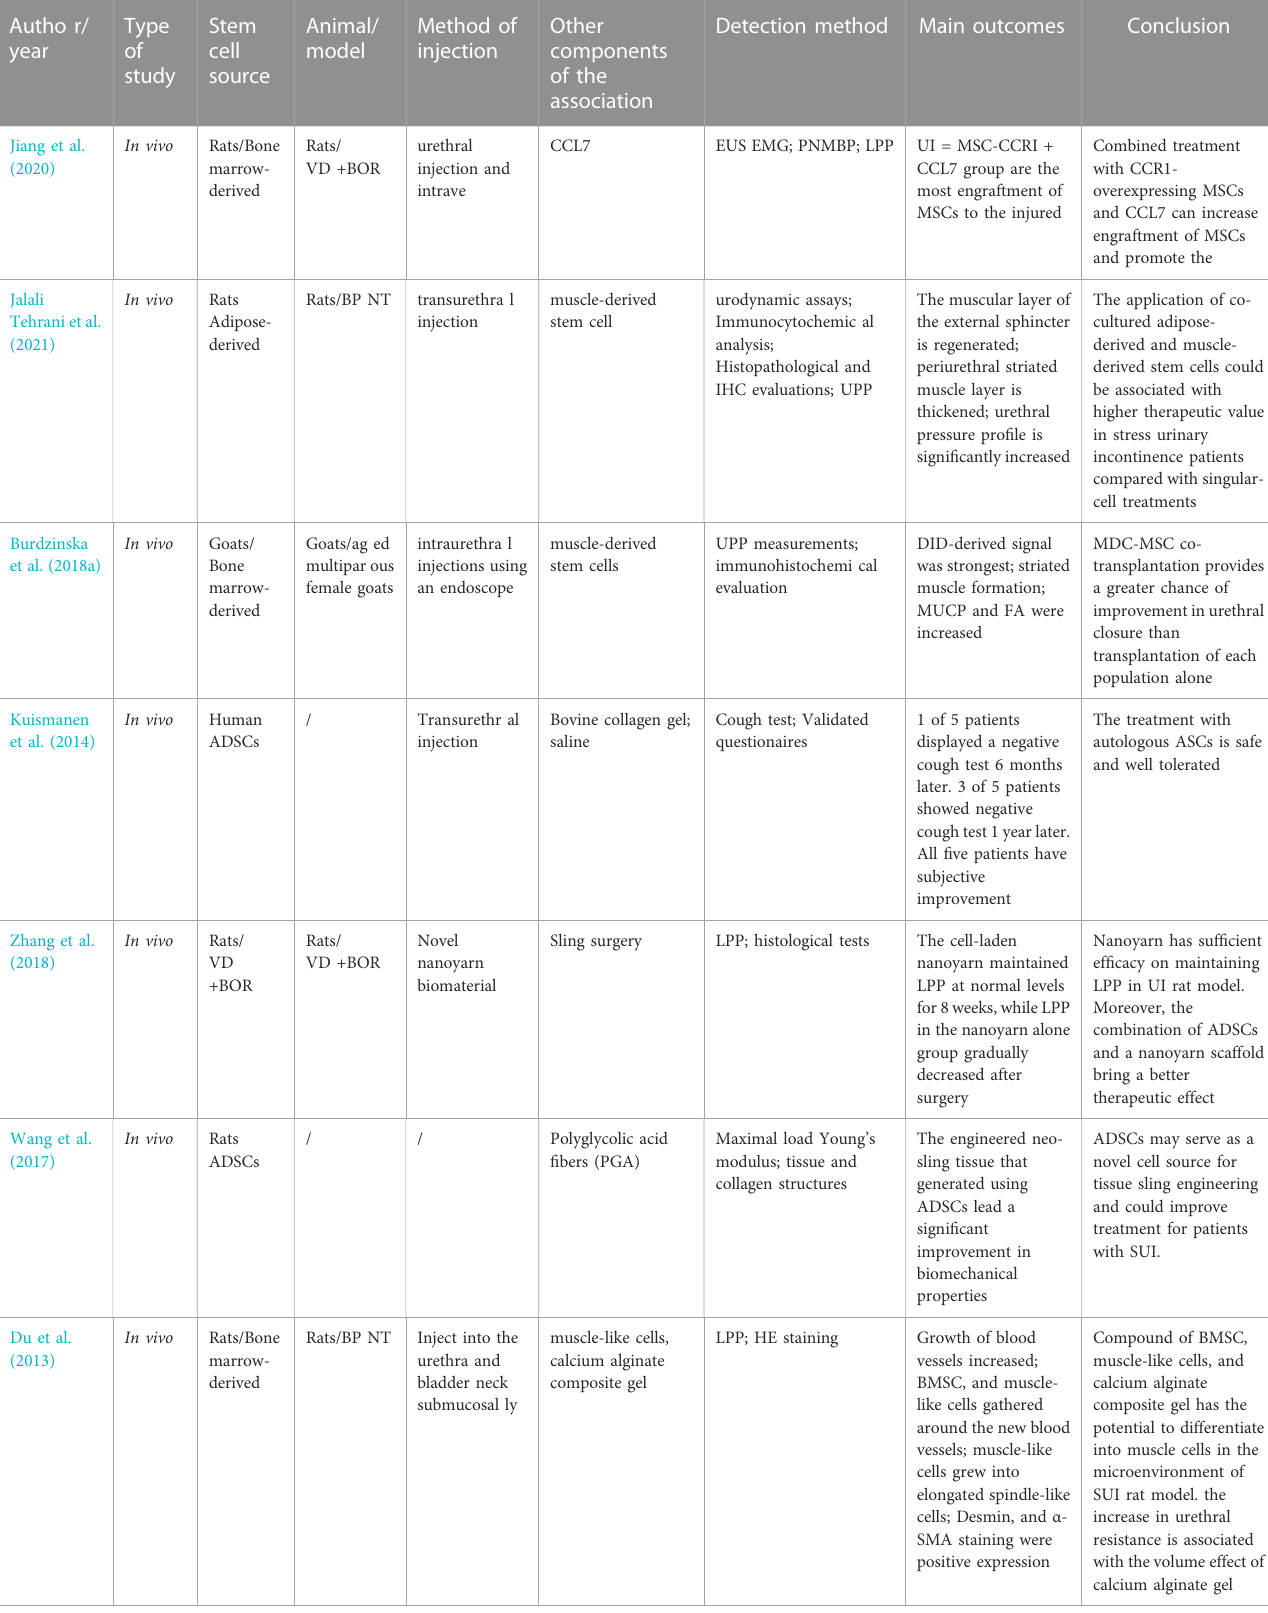
TABLE 2 Study characteristics dealing with MSC based combination therapy for stress urinary